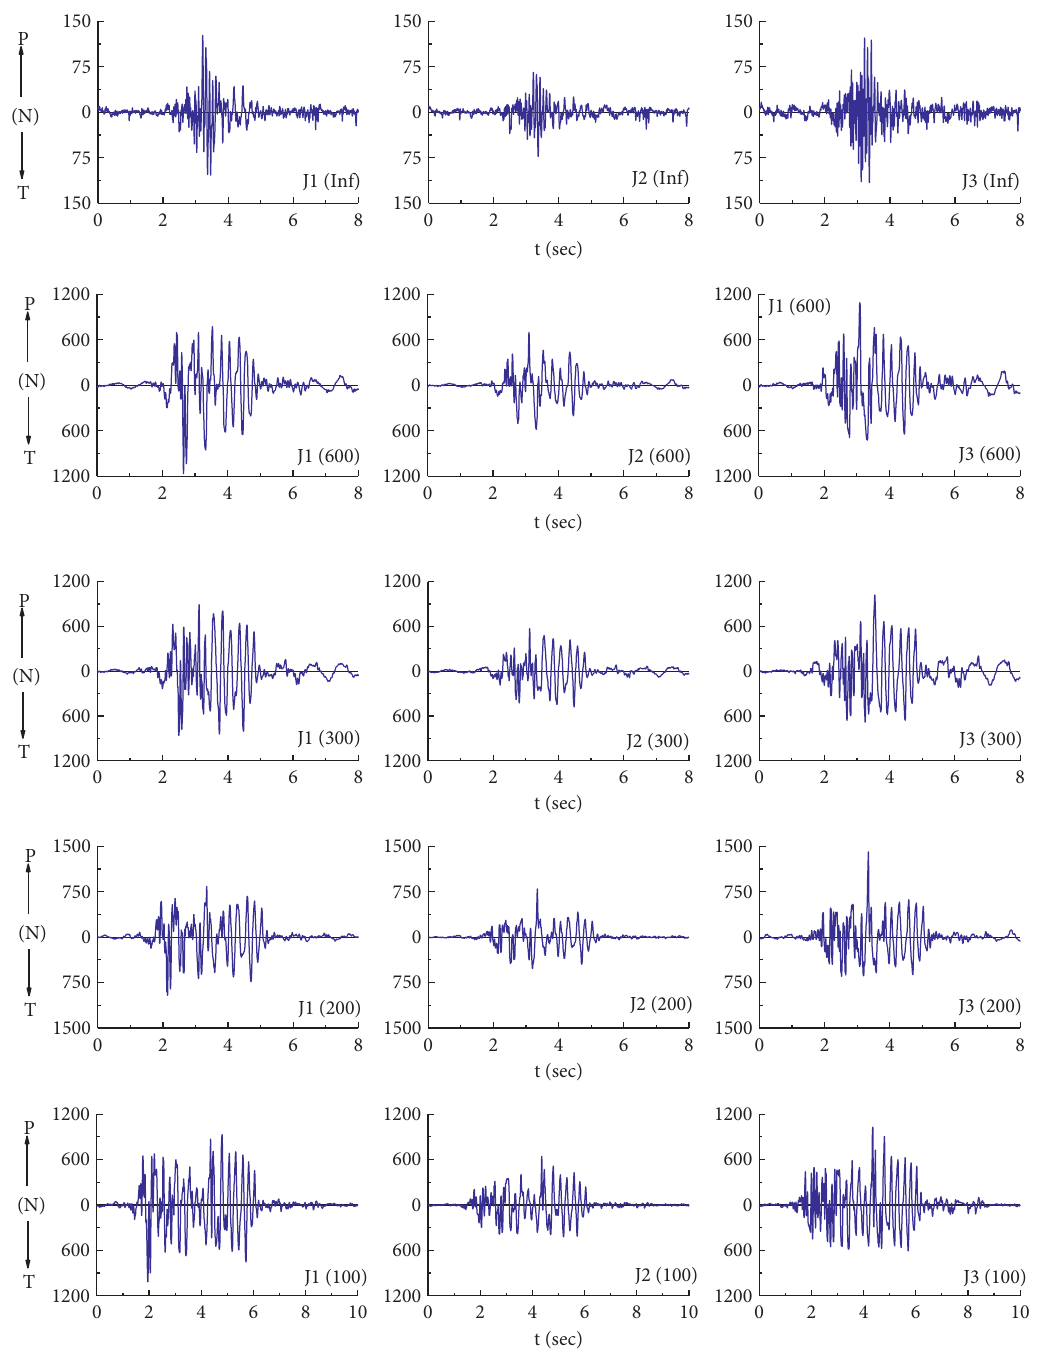
Figure 13: Axially force of